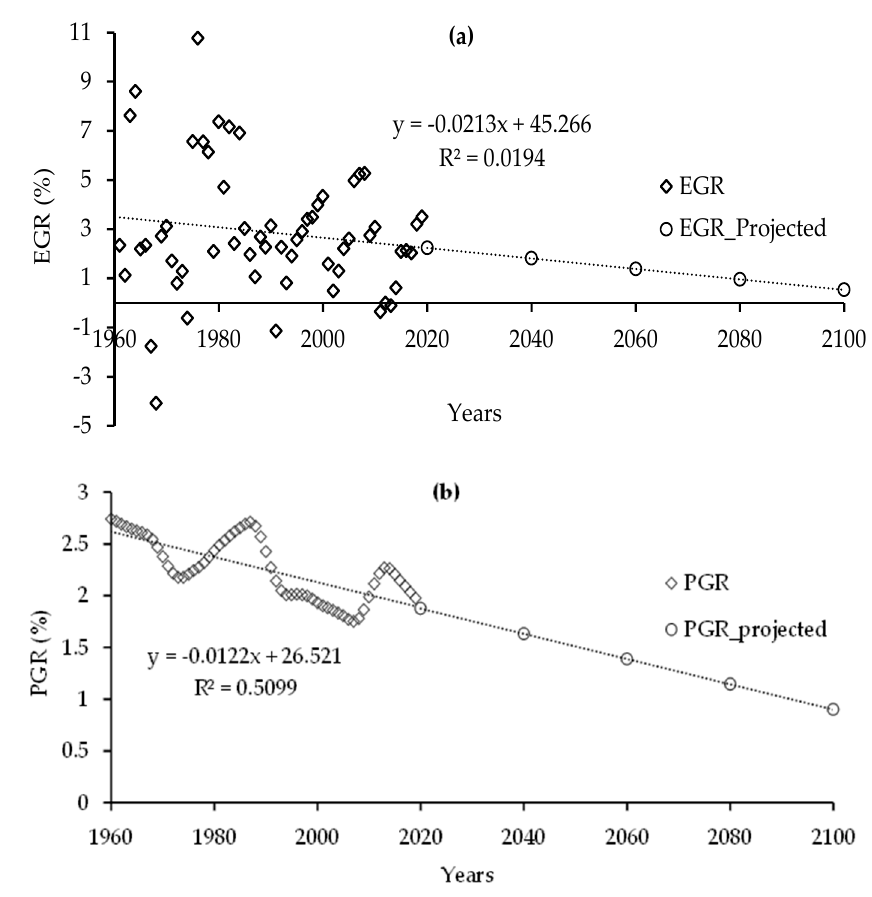
Figure 5. ( a ) Economic Growth Rate and ( b ) Population Growth Rate of Egypt [40,41].